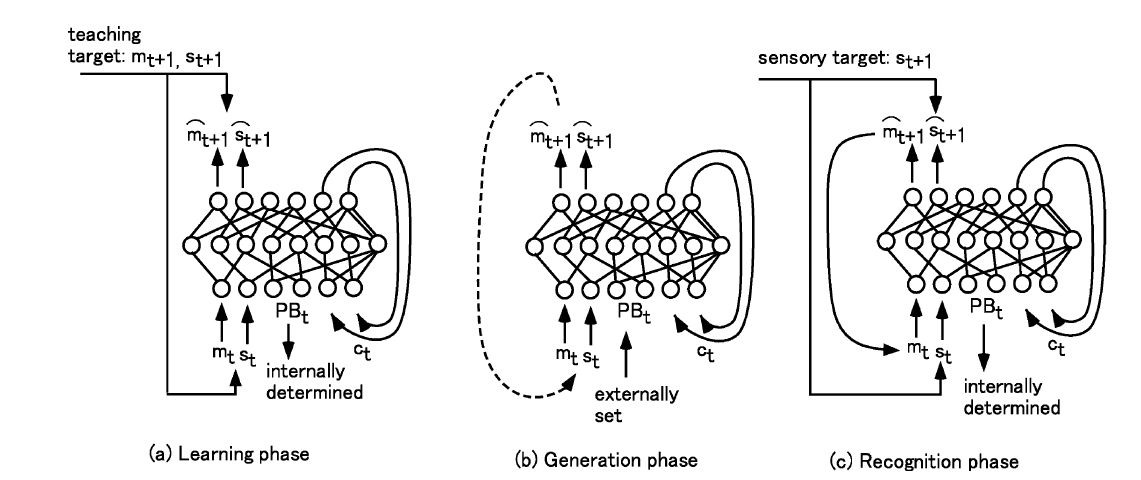
Figure3. ThesystemflowofRNNPBinlearning( a ),generation( b )andrecognition( c ) .Notethatgenerationandrecognitioncanbeconductedsimultaneously. PB t and c t denote the PB vector and the context activation